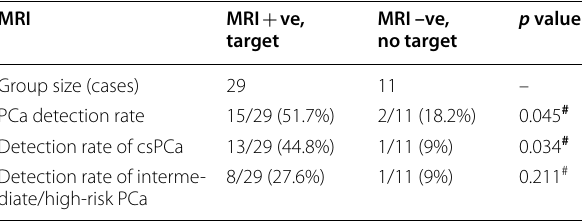
Table 1 Comparison histopathologic result of MRI MRI ve −